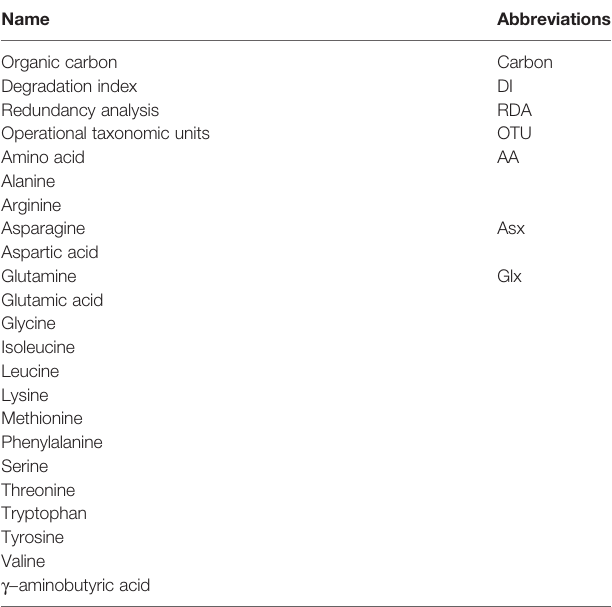
TABLE 1 | The detected AAs list and key abbreviations used in this work.